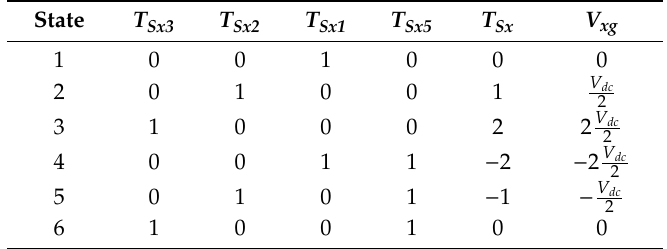
Table 1. Switching state of five-level H-bridge T-type inverter (5L-HBT 2 I) for phase- x index.